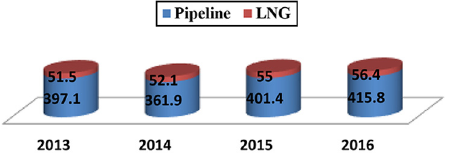
Figure 1. European imports